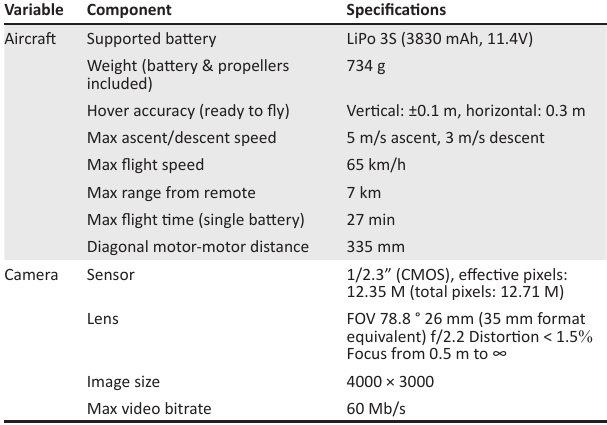
TABLE 1-A1: Aircraft Specifications taken from the website of DJI (2018). Variable Component